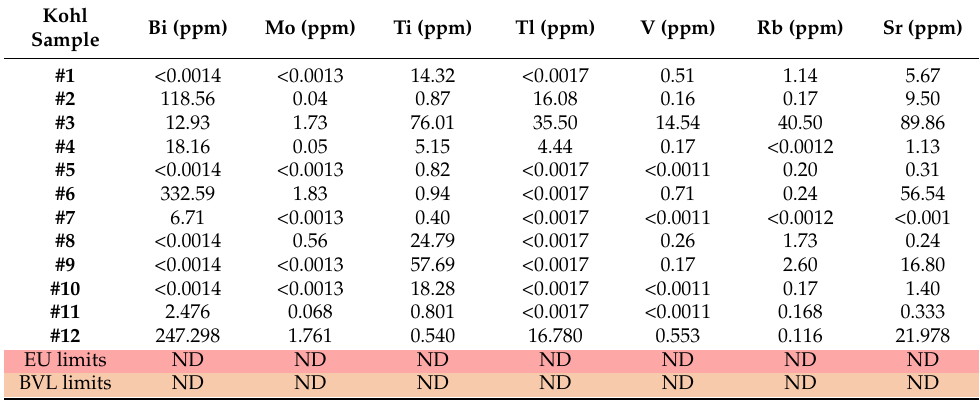
Table 7. Concentrations of elements ( ppm or µ g/g) in kohl samples compared to the limitations established by governmental institutions. Orange boxes indicate values above the German Federal exceed the European Union legal limits [40]. ND : not